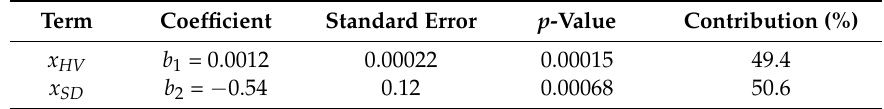
Table 6. The regression coefficients, standard errors, p -values, and contributions for the model of case depth with the non-ground sample data set. The intercept term is b 0 = − 0.51. Term